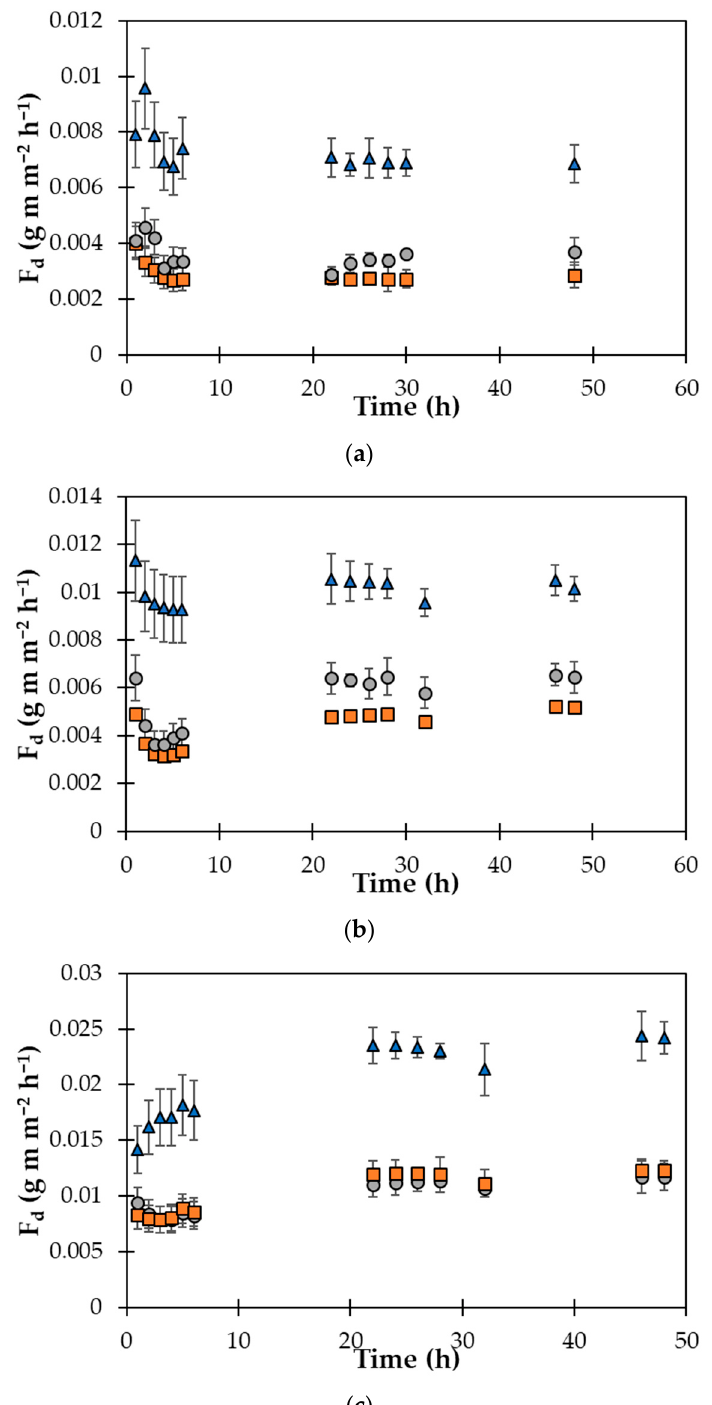
Figure 6. F d as a function of the time for the native ( ), MGLQ ( ), and MGHQ ( ) membranes at ( a ) 20, ( b ) 40, and ( c ) 60 °C.